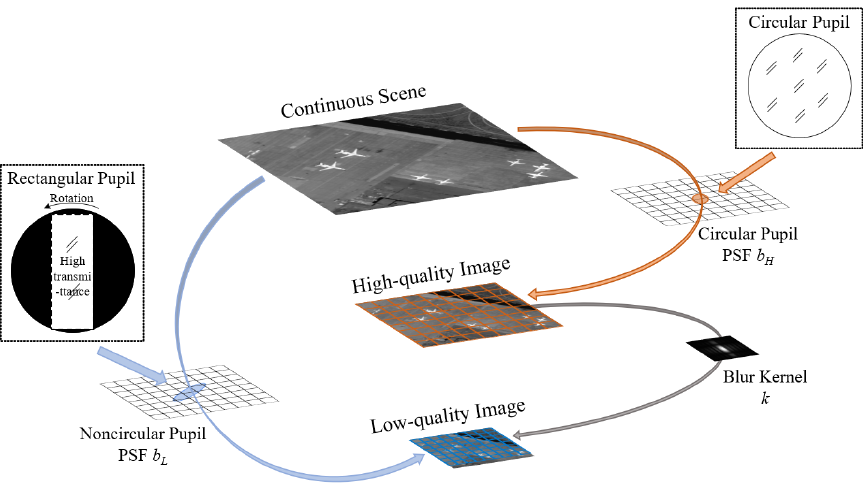
Figure 4. Relations between the discrete-domain low-quality image, the discrete-domain high-quality image, and the continuous-domain scene.